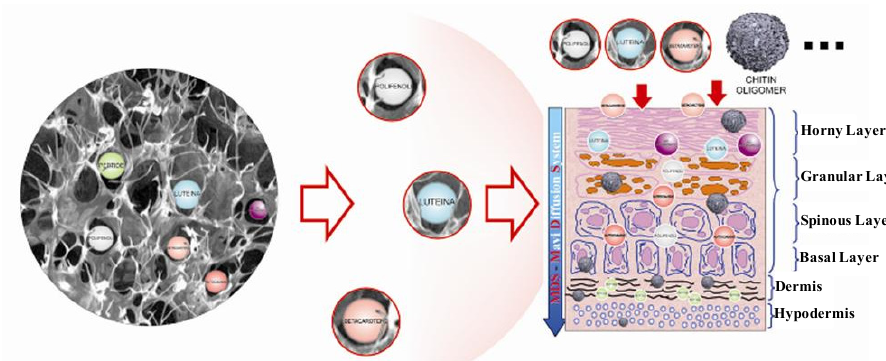
Figure 8. CN-HA has the capacity to disturb the stratum corneum lamellae organization, increasing the skin penetrability of the active ingredients